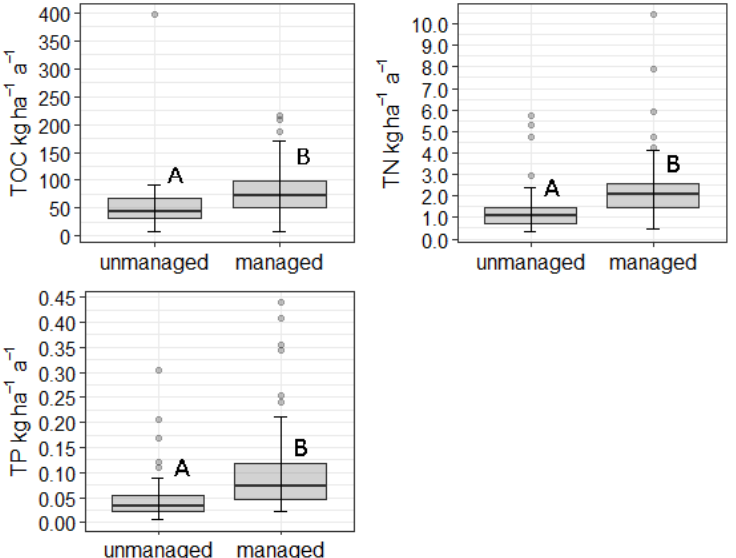
Figure 3. The annual export of TOC, TN and TP in managed and unmanaged catchments over the monitoring period (2014–2018). The horizontal line in the box is the median. The boxes indicate the interquartile range, while whiskers show the largest and smallest value within 1.5 times interquartile range above 75th percentile and 1.5 times below 25th percentile, with dots showing observations outside of these. The capital letters denote statistical differences, with different letters indicating a significant difference between unmanaged and